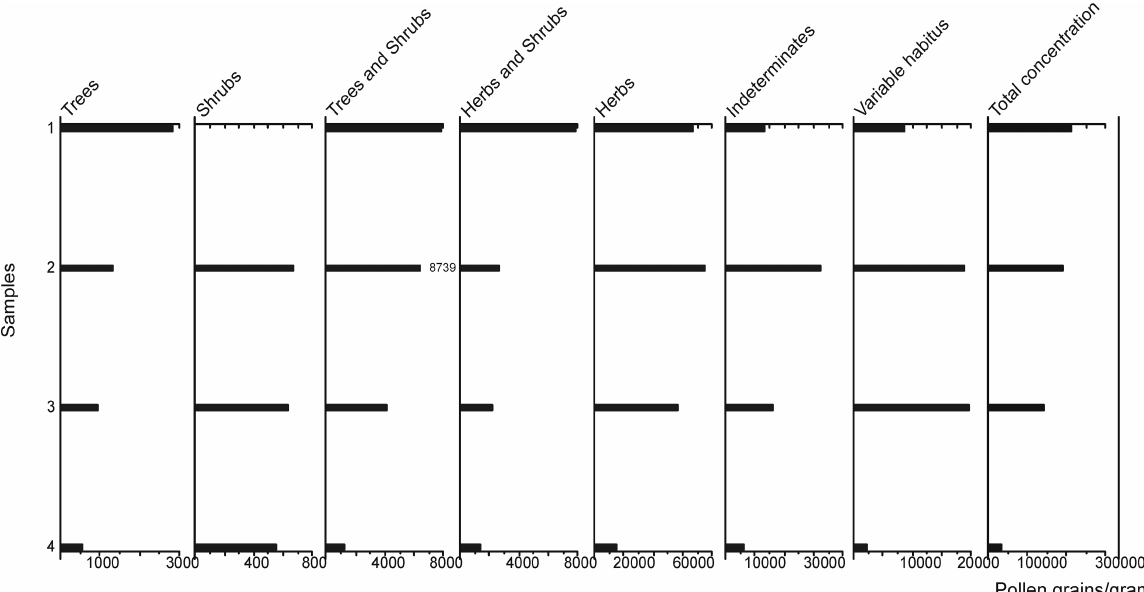
Fig. 6 – Total concentration of pollen grains according to the plant habitus, spores of Pteridophyta and algae, at the surface samples of the Lagoa do Campelo